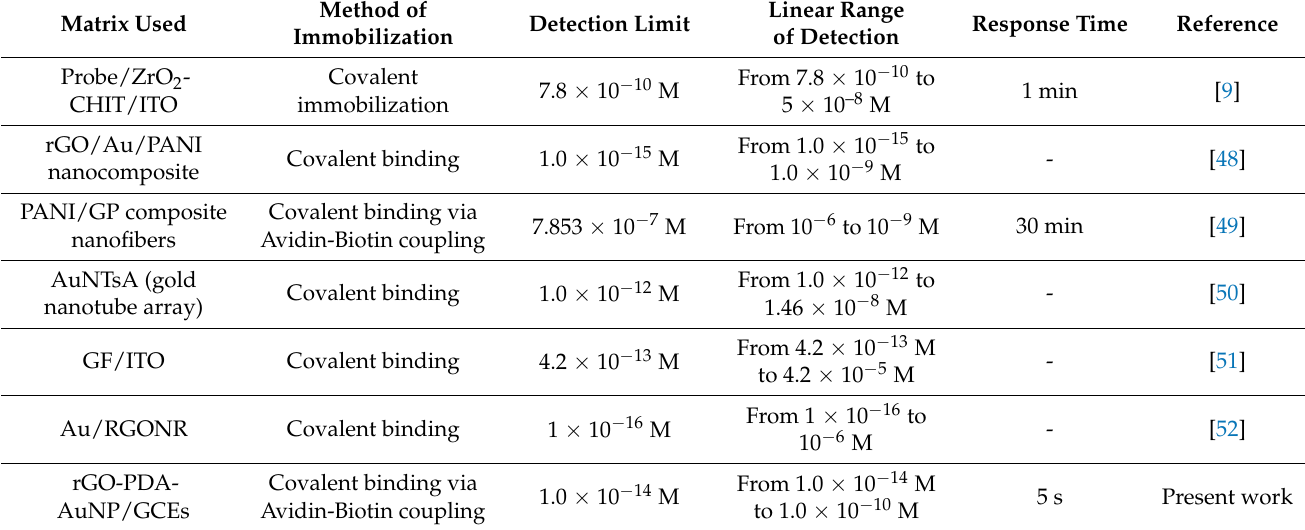
Table 1. Comparison of the biosensing properties of the ssDNA/rGO-PDA-AuNP/GCE bioelectrode with other carbon nanomaterials-based genoelectrodes for MTB